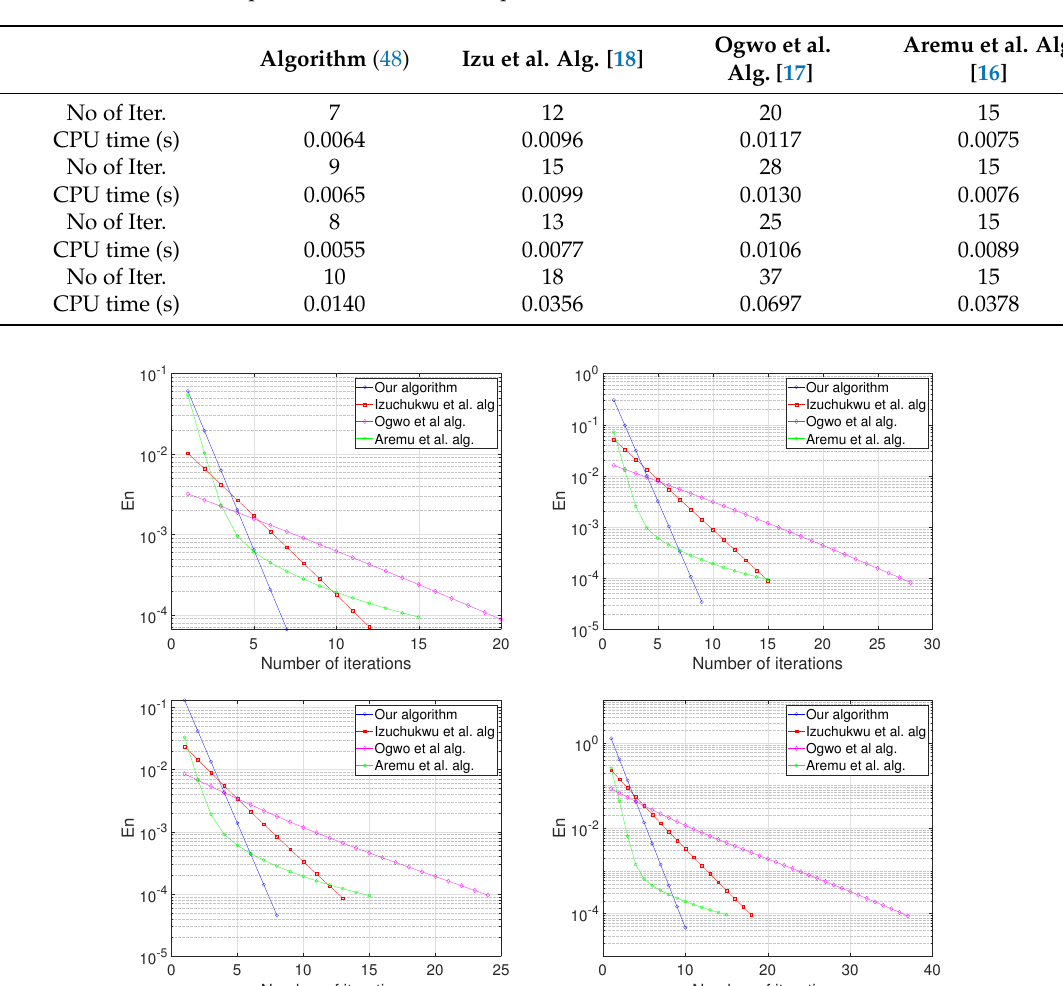
Table 2. Computation results for Example 2.